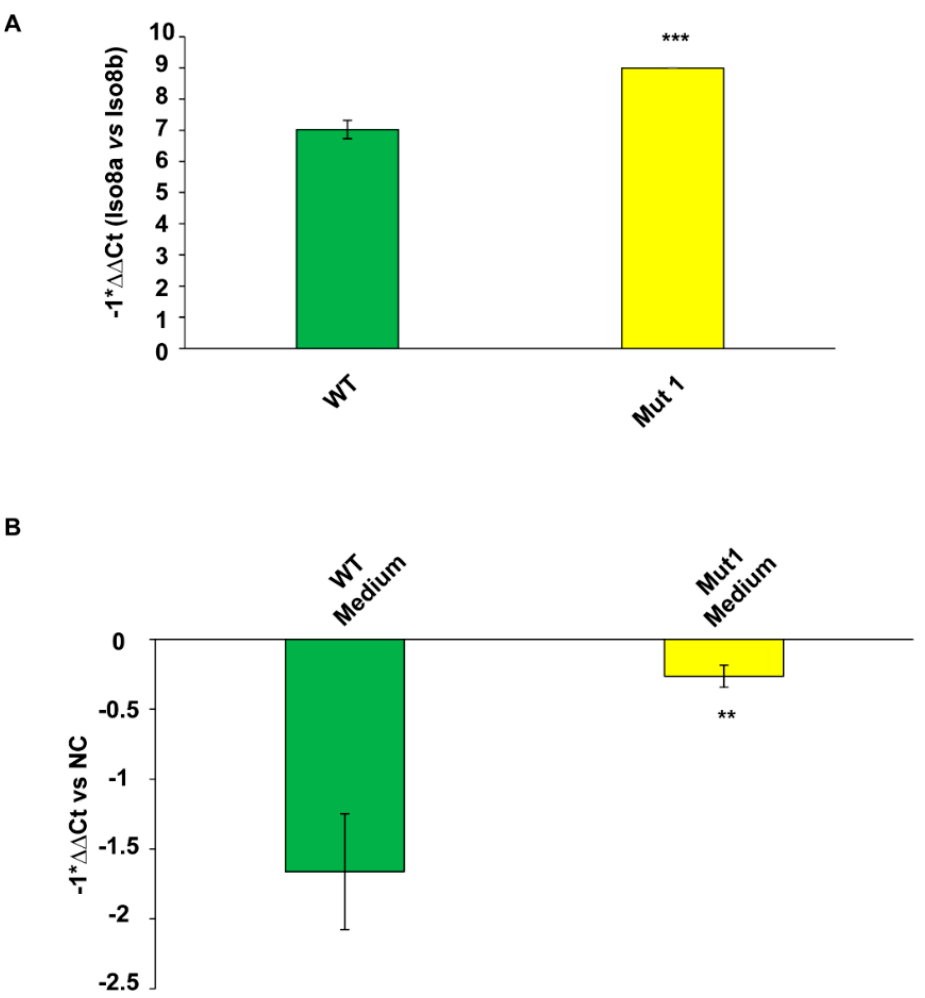
Figure 5. CAS-1 transfected with Mut1 circSMARCA5 show an increased ( A ) intracellular Iso8a to Iso8b VEGFA mRNA isoform ratio and ( B ) amount of secreted total VEGFA mRNA in cell culture medium as compared to CAS-1 transfected with WT circSMARCA5. ( A ) Data are represented as mean ± standard deviation of − 1* ∆∆ Ct (the lower the value, the lower the relative expression of intracellular Iso8a vs. Iso8b VEGFA mRNA isoform; vice versa, the higher the value, the higher the intracellular Iso8a to Iso8b mRNA isoform ratio). ∆ Ct values of each mRNA isoform were calculated from qRT-PCR experiments by using TATA-box binding protein (TBP) mRNA as endogenous control. ∆∆ Ct was obtained subtracting ∆ Ct of Iso8b to ∆ Ct of Iso8a. ( B ) Data are represented as mean ± standard deviation of − 1* ∆∆ Ct (the lower the value, the lower the expression of total VEGFA mRNA in cell culture medium; vice versa, the higher the value, the higher, the expression of total VEGFA mRNA in cell culture medium). Actin beta (ACTB) mRNA was used as endogenous control to calculate ∆ Ct. Cell culture medium from CAS-1 transfected with an empty pcDNA3 vector (negative control, NC) was used as a calibrator to calculate ∆∆ Ct. *** p -value < 0.001, ** p -value < 0.01 ( n = 3, Student’s t -test vs. WT).